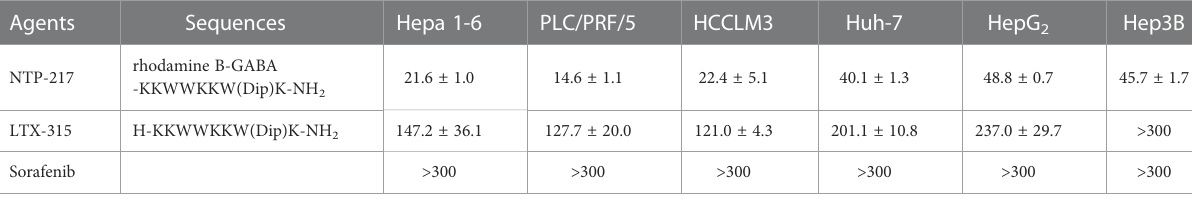
TABLE 1 Comparison of the half-maximal inhibitory concentration of NTP-217, LTX-315 and sorafenib on liver cancer cells for 4 h.